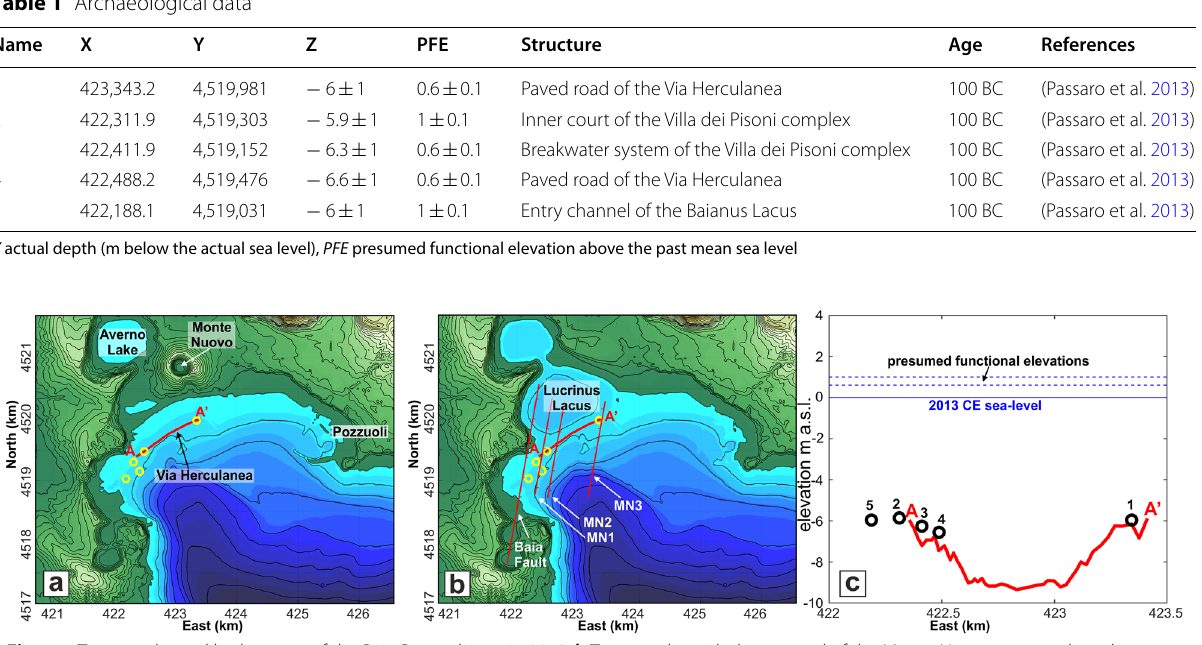
Fig. 4 a Topography and bathymetry of the Baia-Pozzuoli area in 2013. b Topography with the removal of the Monte Nuovo cone and products such as reconstructed by Di Vito et al. (1987) and Ascione et al. (2020). c Current elevations of the archaeological data and profile A–A’, the latter corresponding to the Via